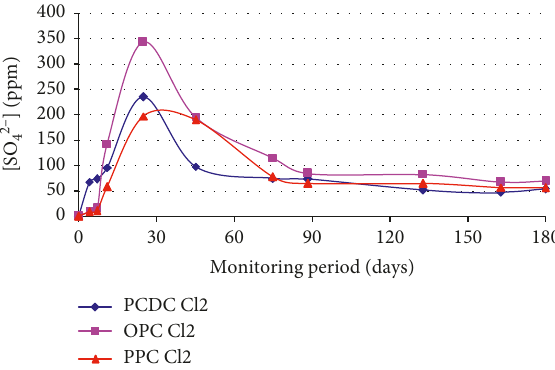
Figure 1: Cl analyses in chloride-simulated solution 1. −